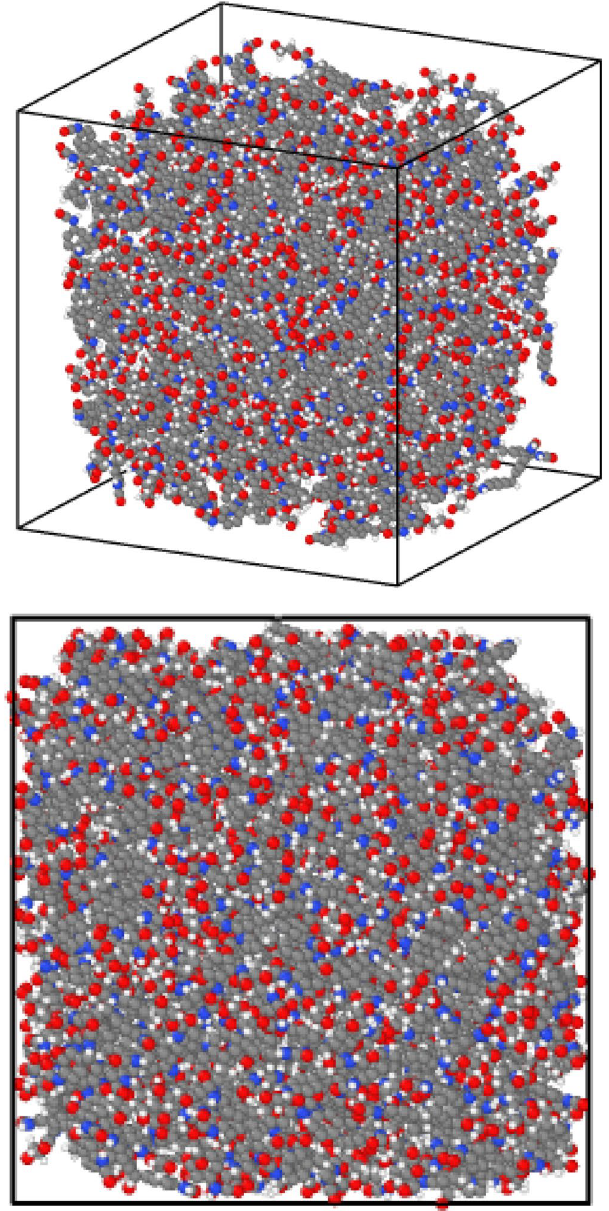
Figure 1. View of the atomic structure of a simulated concrete